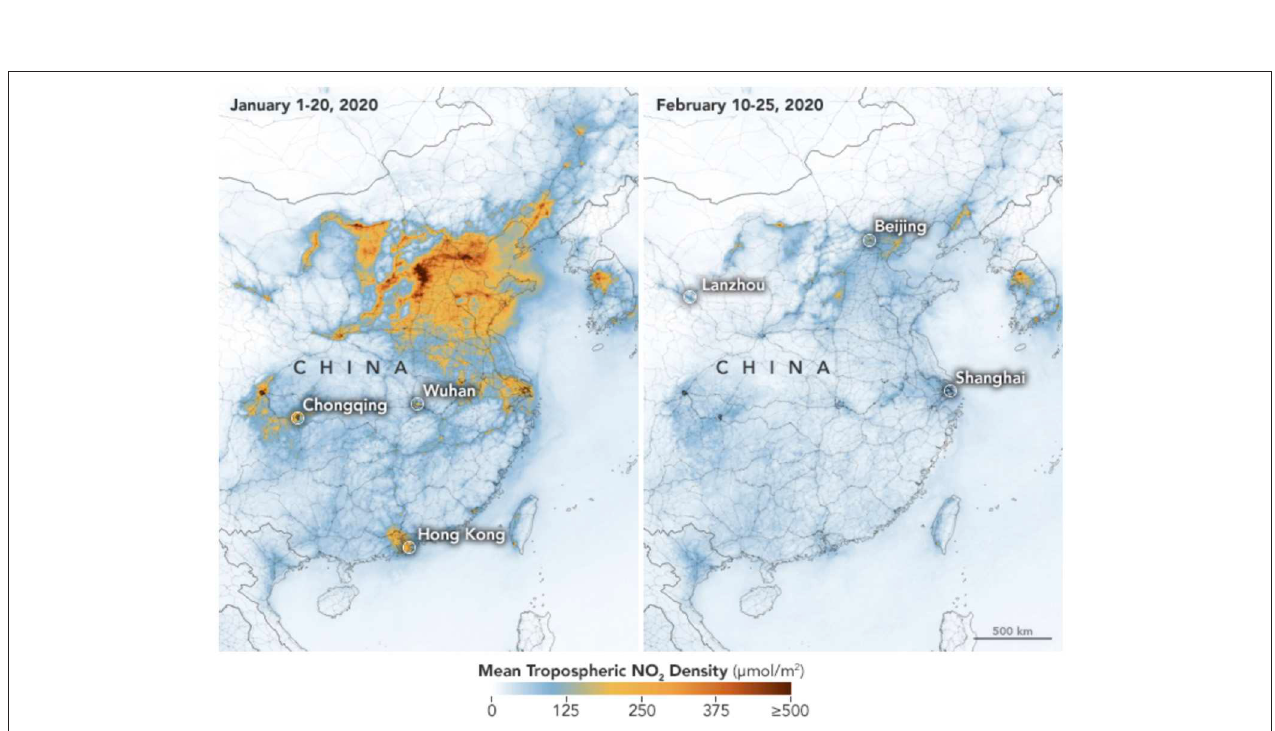
FIGURE 7 | Changes in NO 2 concentration due to COVID-19 lockdown in China using data collected from TROPOMI from ESA’s Sentinel-5P satellite (Credit: NASA Earth Observatory images by Joshua Stevens, using modified Copernicus Sentinel 5P data processed by the ESA).